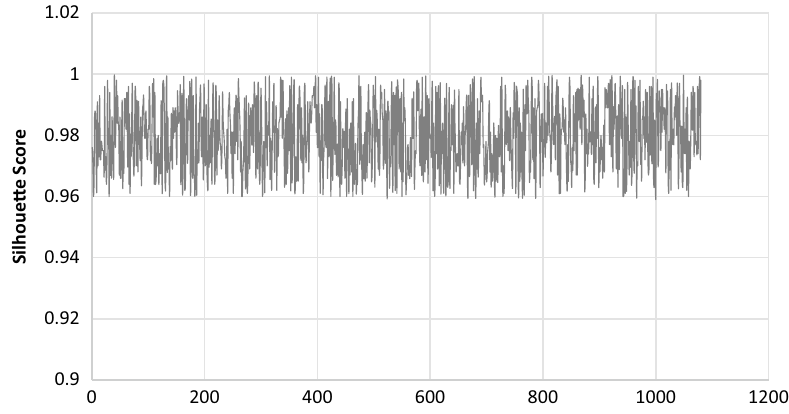
Fig. 15 Validation Silhouette score